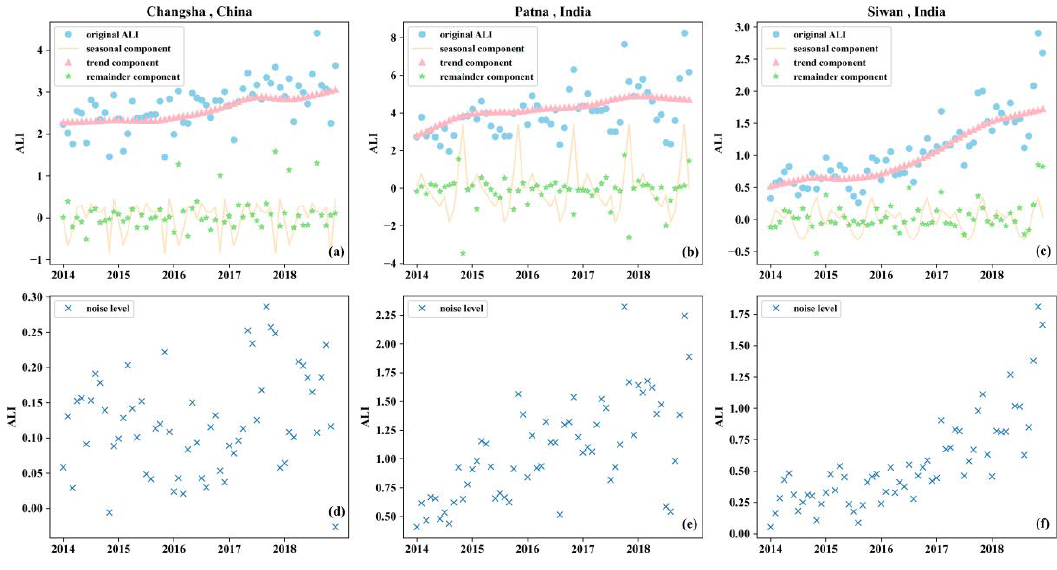
Figure 13. Trends ( a ), ( b ), ( c ) and background noise threshold ( d ), ( e ), ( f ).